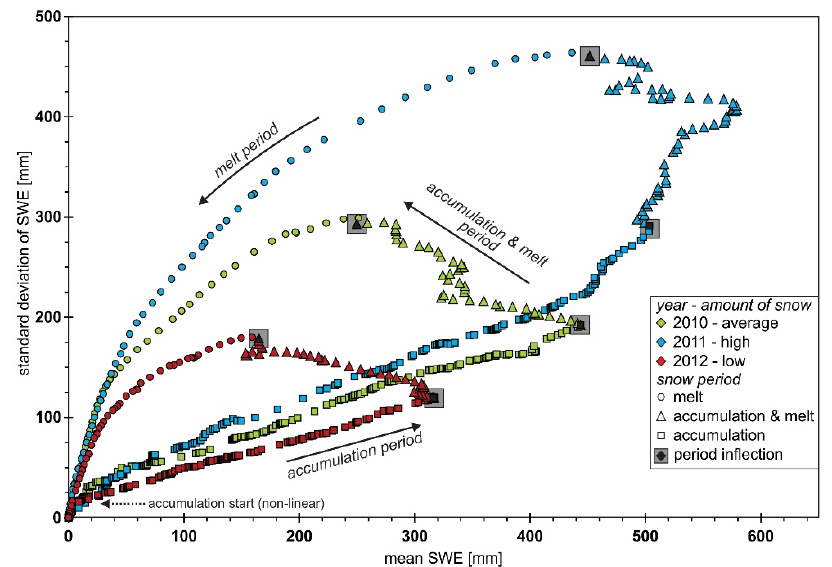
Figure 3. Standard deviation versus mean SWE trajectory across the full domain for an average snow year 2010, high snow year 2011, and low snow year 2012, with accumulation start (non-linear) as a dashed arrow, and the accumulation/melt inflection points identified. The approximate accumulation phase at all stations (square symbol), accumulation at some stations & melt at others (triangles symbol) and melt at all stations (round symbol). The three solid arrows show evolution over time, illustrating the direction of accumulation, accumulation & melt, and melt periods.